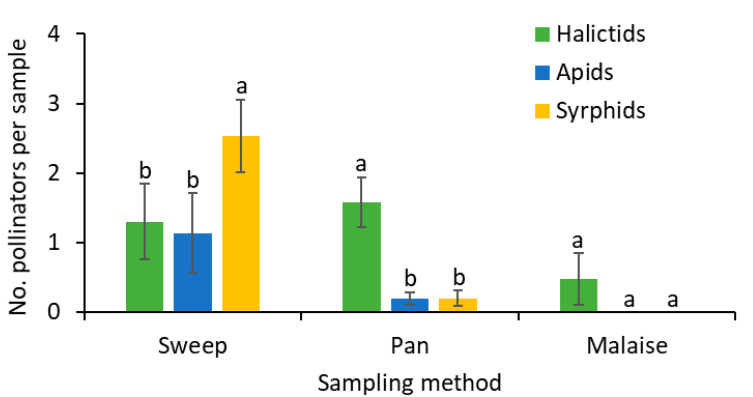
Figure 3. Mean (±SE) numbers of pollinators collected by three sampling methods. Within each trap type, the bars with a different letter are significantly different (Tukey’s HSD test, p = 0.05).